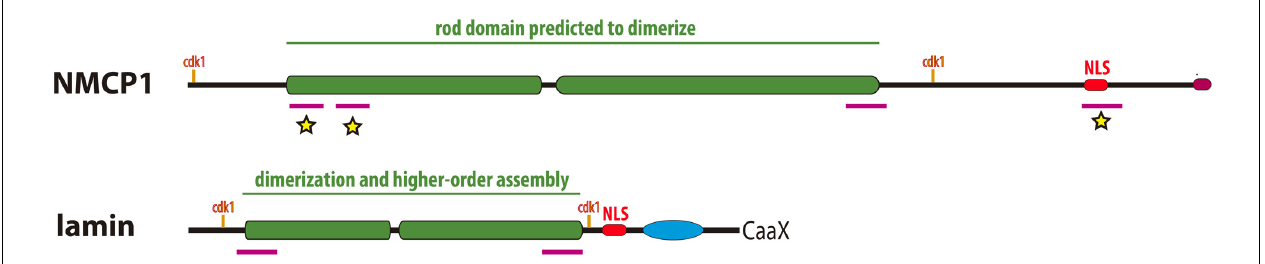
lamins.The rod domain is flanked by conserved cdk1 phosphorylation sites in both cases. In the tail domain both have a NLS (red boxes) and a conserved C-terminus (magenta box in NMCP1 and CAAX box in lamins). NMCPs lack the Ig fold for partner protein binding typical of lamins (blue oval).The conserved regions marked with a yellow star are involved in NMCP1 association to the nuclear periphery (Kimura etal.,